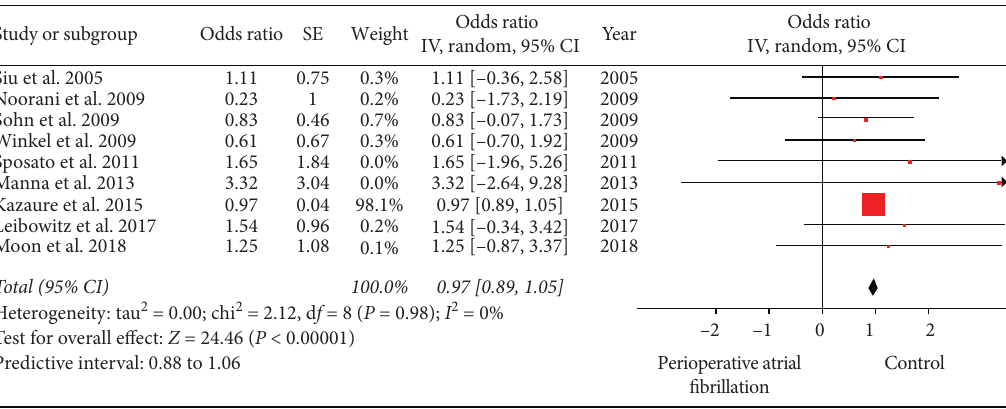
Figure 5: Forest plot evaluating diabetes mellitus as a risk factor for perioperative atrial fibrillation in patients undergoing non- cardiothoracic surgery. The odds ratio of each included study is plotted. A pooled estimate of overall odds ratio (diamonds) and 95% confidence intervals (width of diamonds) summarizes the effect size using the random effects model. CI � confidence